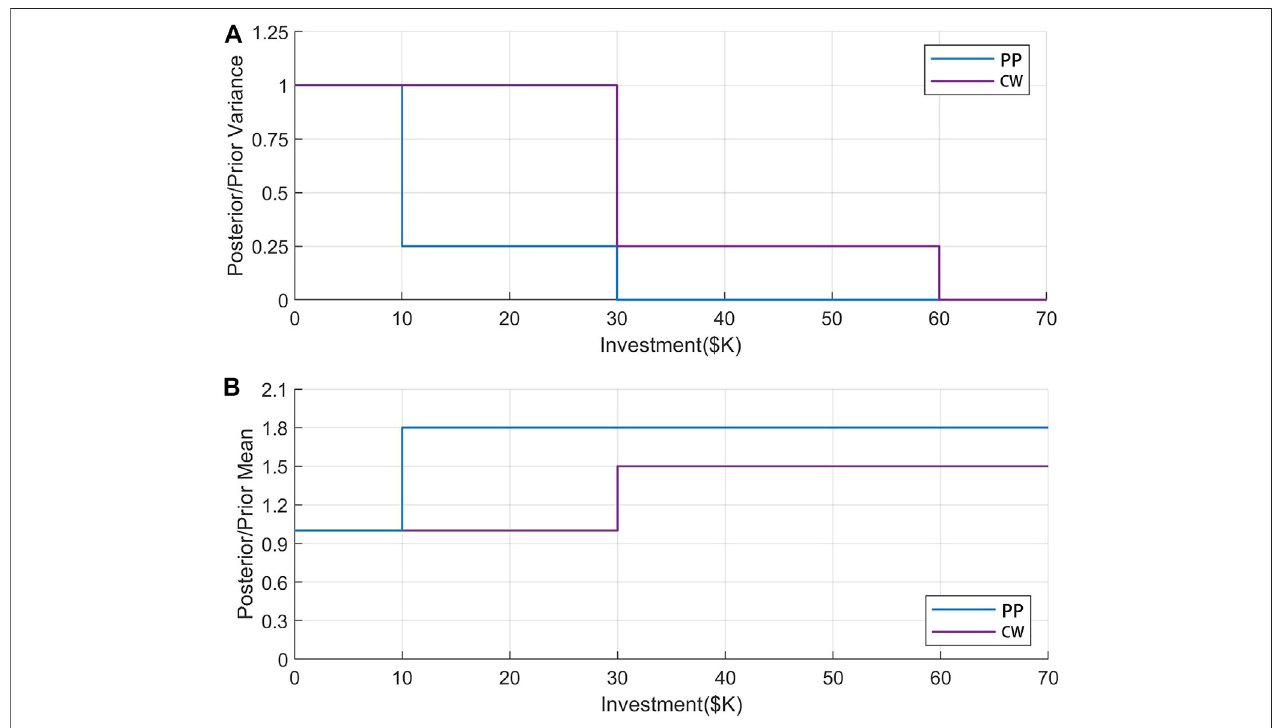
FIGURE 3 | (A) Variance learning curve functions used in the VL and the MVL models and (B) learning curve functions for the expected value improvement in the MVL model.